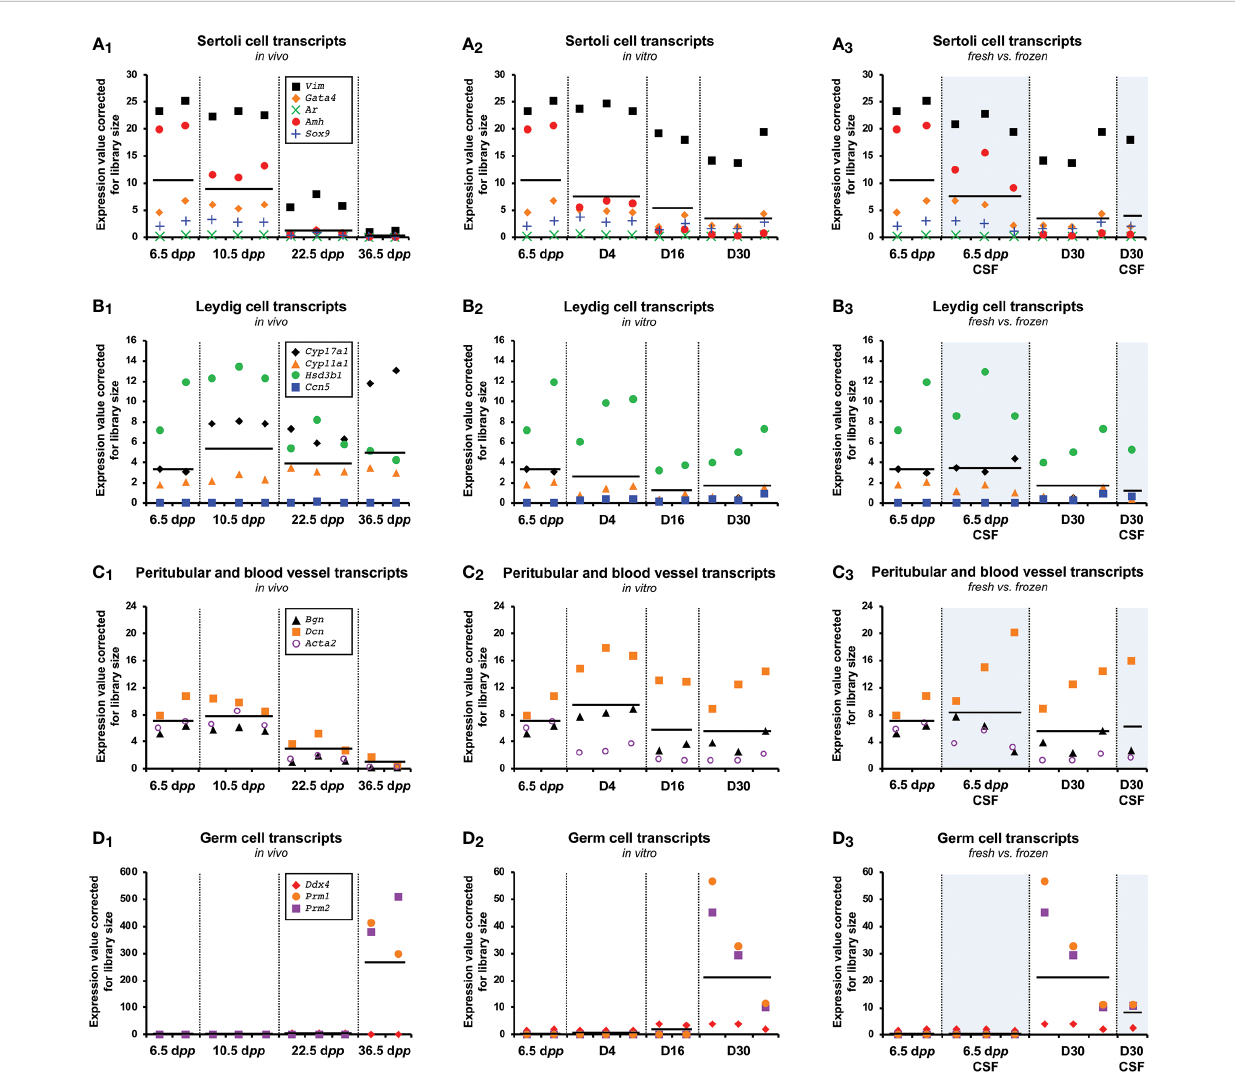
FIGURE 5 Cell gene expression during the fi rst spermatogenic wave. Known Sertoli ( Vim , Gata4 , Ar , Amh , Sox9 ) (A 1-3 ) , Leydig ( Cyp17a1 , Cyp11a1 , Hsd3b1 , Ccn5 ) (B 1-3 ) , peritubular/blood vessel ( Bgn , Dcn , Acta2 ) (C 1-3 ) , and germ cell ( Ddx4) /elongated spermatids ( Prm1 , Prm2 ) (D 1-3 ) markers expressed in the testis or testicular explants during the fi rst wave of spermatogenesis for in vivo (A 1 , B 1 , C 1 , D 1 ) , in vitro (A 2 , B 2 , C 2 , D 2 ) and fresh vs . frozen (A 3 , B 3 , C 3 , D 3 ) samples. Horizontal black lines indicate the mean expression values in each group. CSF, controlled slow freezing; d pp , days postpartum